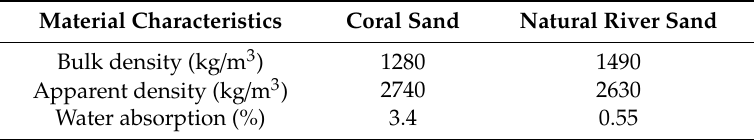
Figure 2. Microstructural morphology of coral sand. Table 3. Physical properties of coral sand and natural river sand.